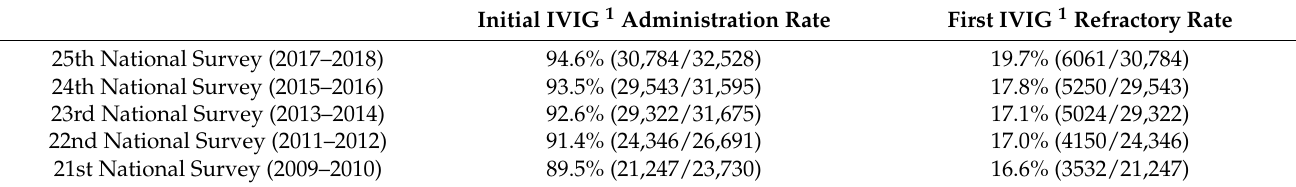
Table 1. First immunoglobulin therapy for Kawasaki disease (KD).